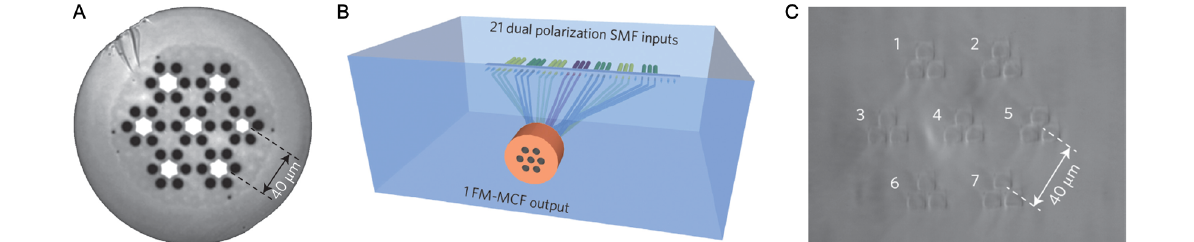
Figure 9: (A) Cross section of a few-moded multicore fibre (FM-MCF). Each one of the 7 cores supports 2 modes, LP 01 and LP 11 . Air holes are placed around the individual cores in order to supress cross-coupling. (B) Schematic of the ultrafast laser inscribed 3D fan-out and mode-multiplexing chip to interface with the FM-MCF. (C) Microscope image of the chip’s end-face showing the array of photonic lantern to perform mode-multiplexing. With permission from [155]. Copyright 2014 Nature Publishing